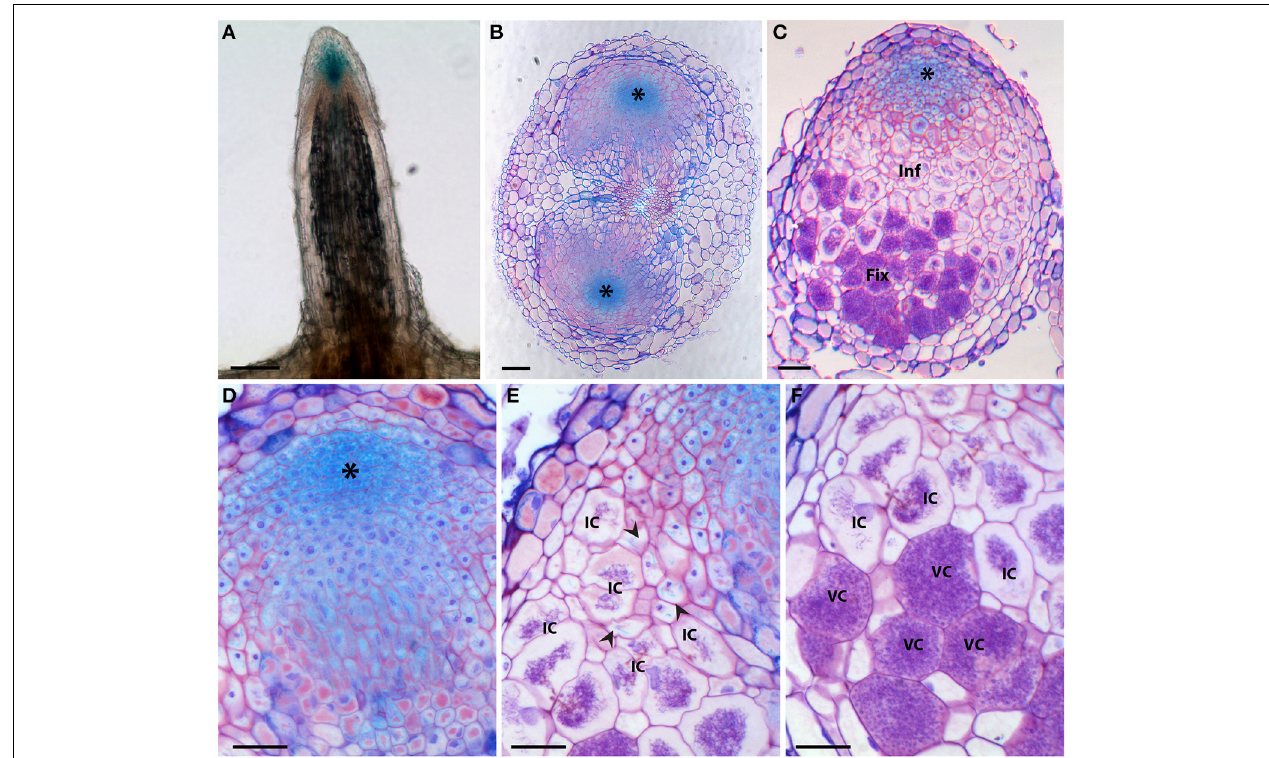
FIGURE 5 | Histochemical localization of β -glucuronidase (GUS) activity in D. trinervis roots expressing a ProDtAUX1:GUS construct. (A) Non-inoculated lateral root; blue staining is detected in the root tip. (B) Cross section of an inoculated root 5 days after inoculation (dai) showing two nodule primordia growing from the pericycle at opposite xylem poles. DtAUX1 expression is observed in the meristematic cells (asterisk). (C) Longitudinal section of a fully developed nodule 21dai. Cells containing Frankia hyphae are stained in purple. GUS activity is intense in the